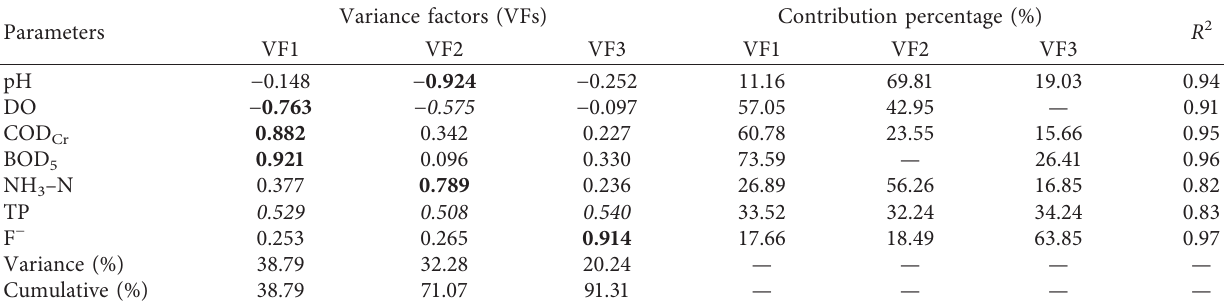
Table 5: Rotated component matrix and contributions of pollutant sources in the nonflood season.